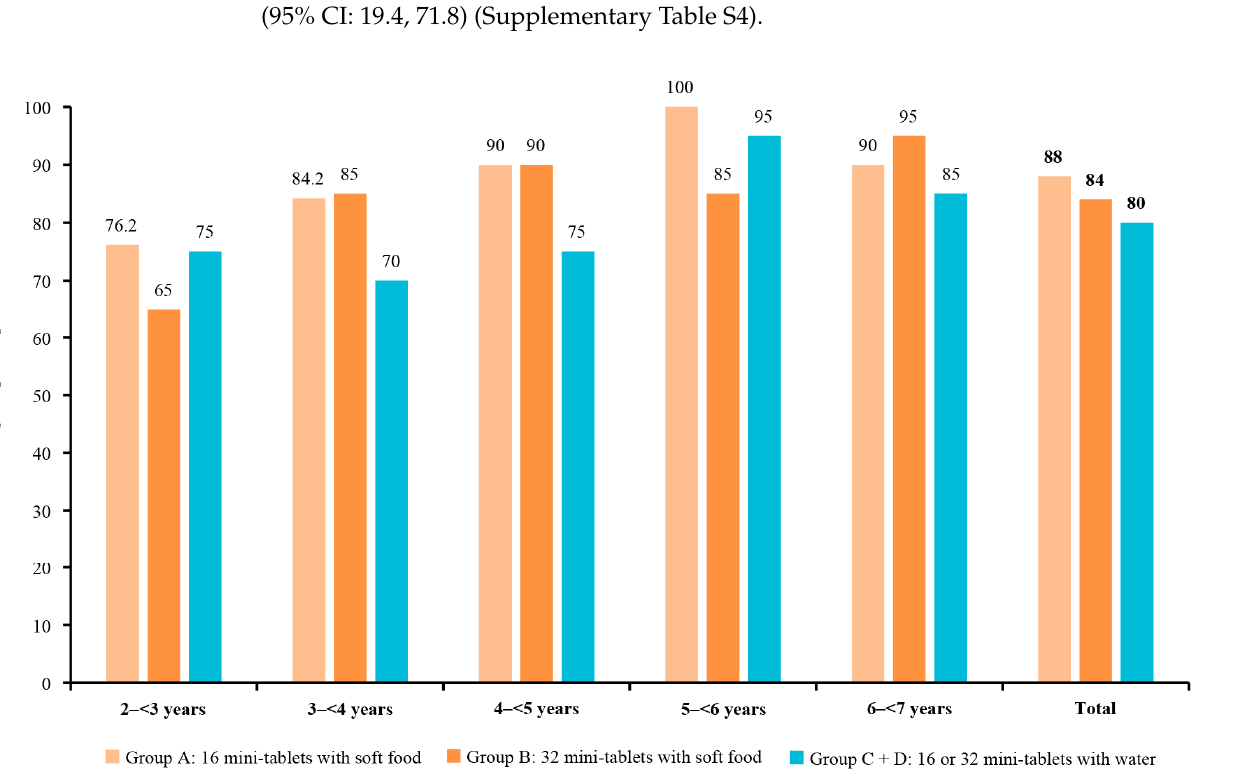
Figure 5. Swallowability of 3 mm placebo mini-tablets by age group. Swallowability was defined as swallowing all of the mini-tablets without chewing, with no residuals of the mini-tablets found in an oral inspection.